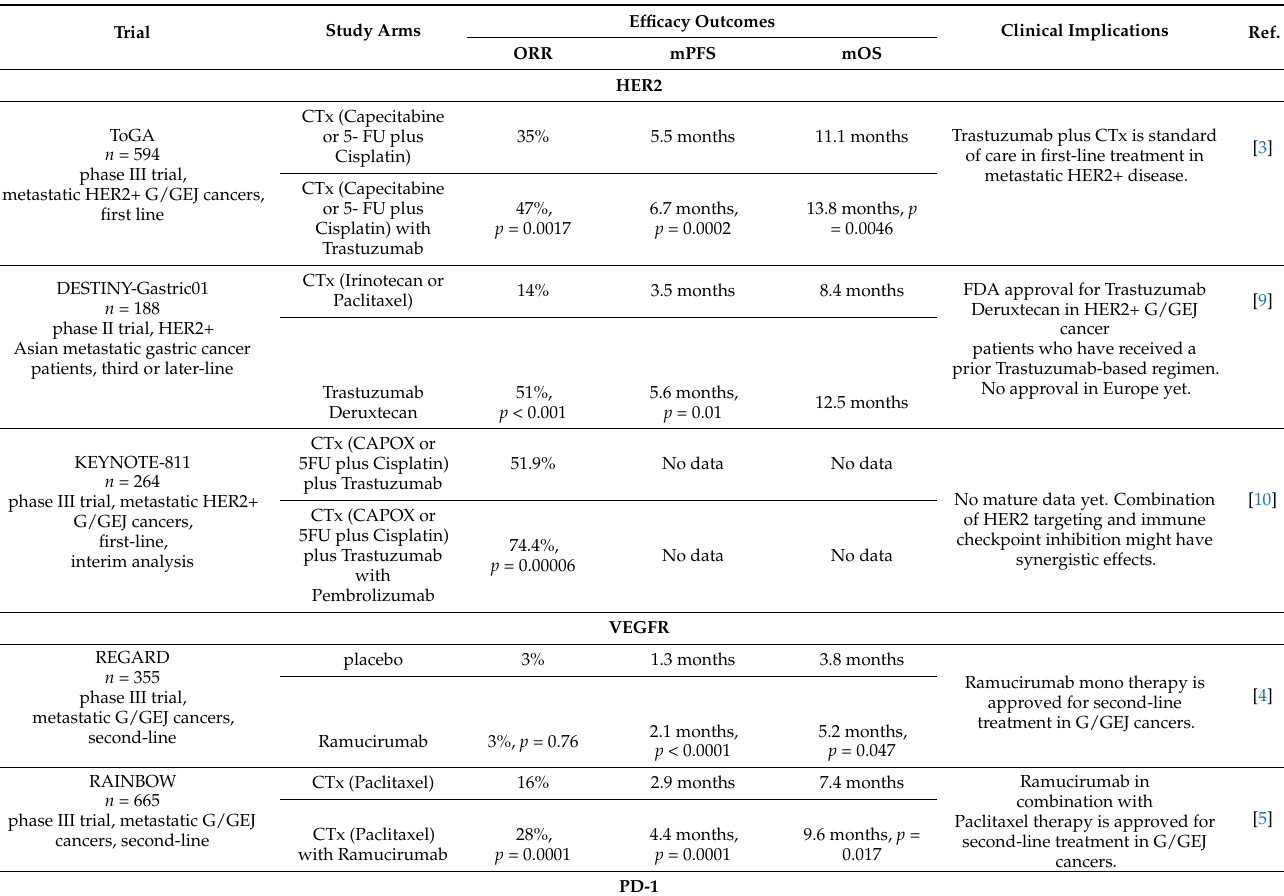
Table 1. Selected pivotal clinical trials in gastric and esophagogastric junction cancers. Trial Study Arms